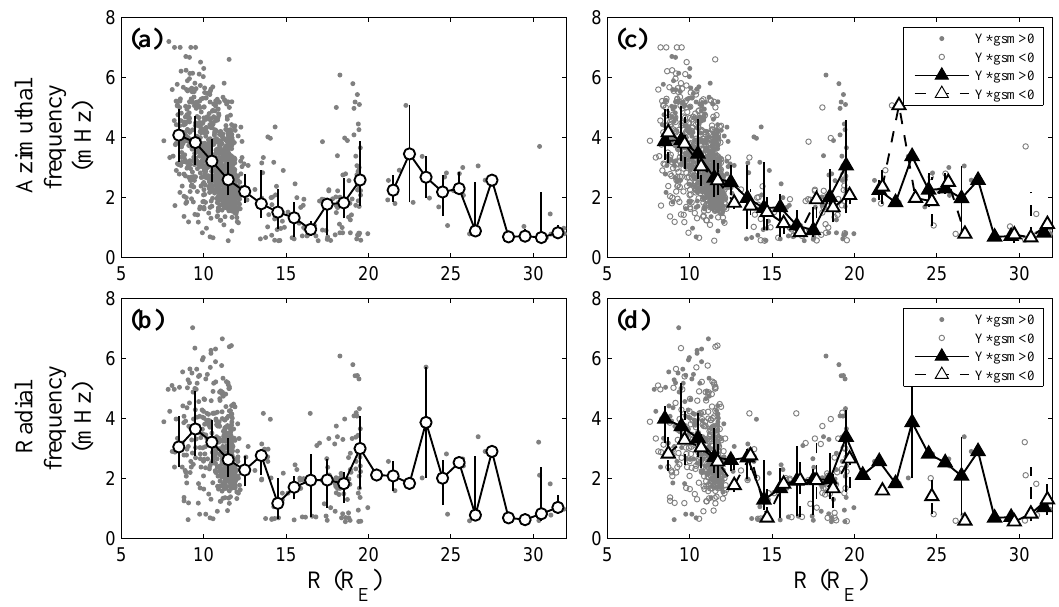
Figure 5. The wave frequency versus radial distance for azimuthal (a, c) and radial (b, d) oscillating events. In panels (a) and (b) , the grey dots are individual events and the open circles are the median values of frequencies in each 1 R E bin. The vertical bars connect the lower and upper quartiles. In panels (c) and (d) , the grey dots and circles indicate the dusk and dawn events, respectively. The solid and open triangles are the same as the open circles in Fig. 5a, but for dusk and dawn events, respectively.